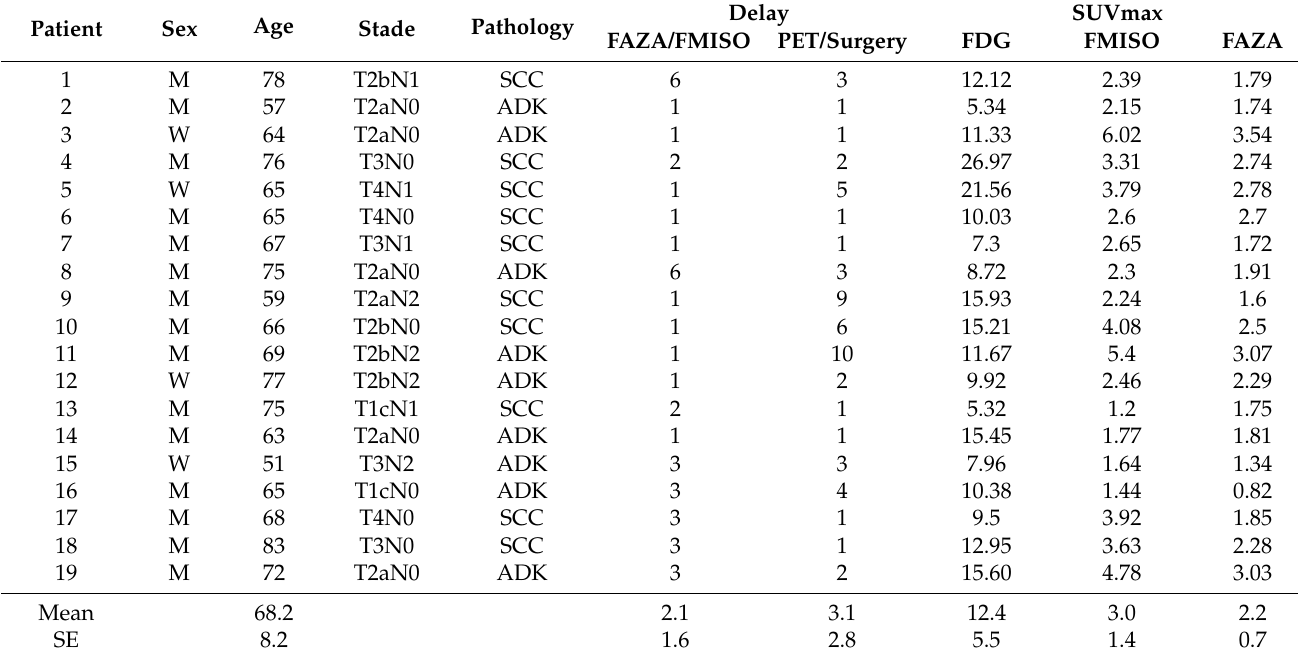
Table 1. Patient